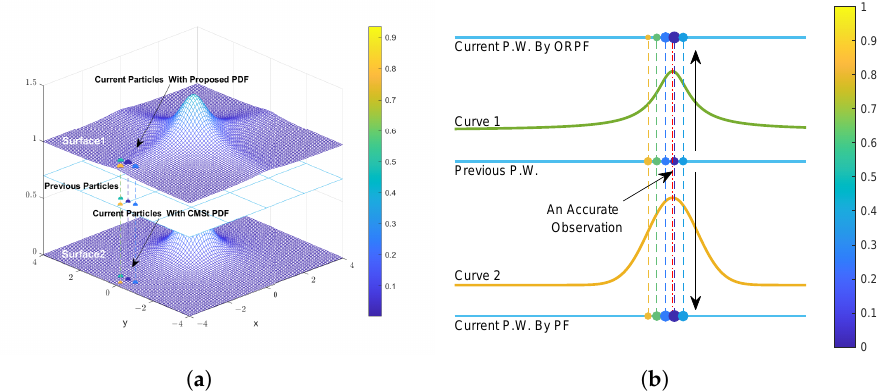
Figure 2. The evolution of particle weights. ( a ) 3D plots of evolution of particle weights. ( b ) slice plots of evolution of particle weights. (Particle weights are denoted by the sizes of their corresponding particle balls, and the particle unreliability is depicted and illustrated by the